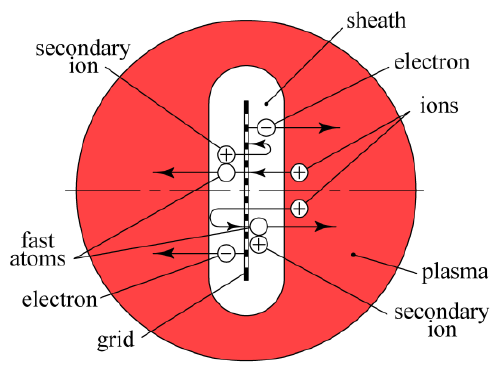
Figure 4. Schematic of fast atoms formation due to charge exchange collisions of ions.